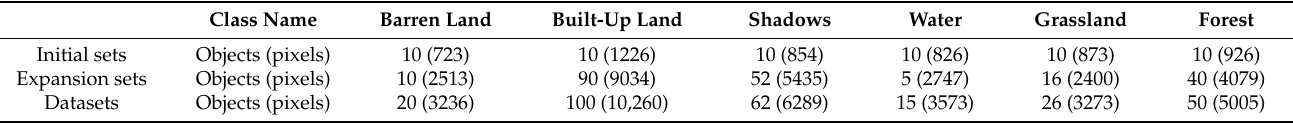
Table 2. Reference samples